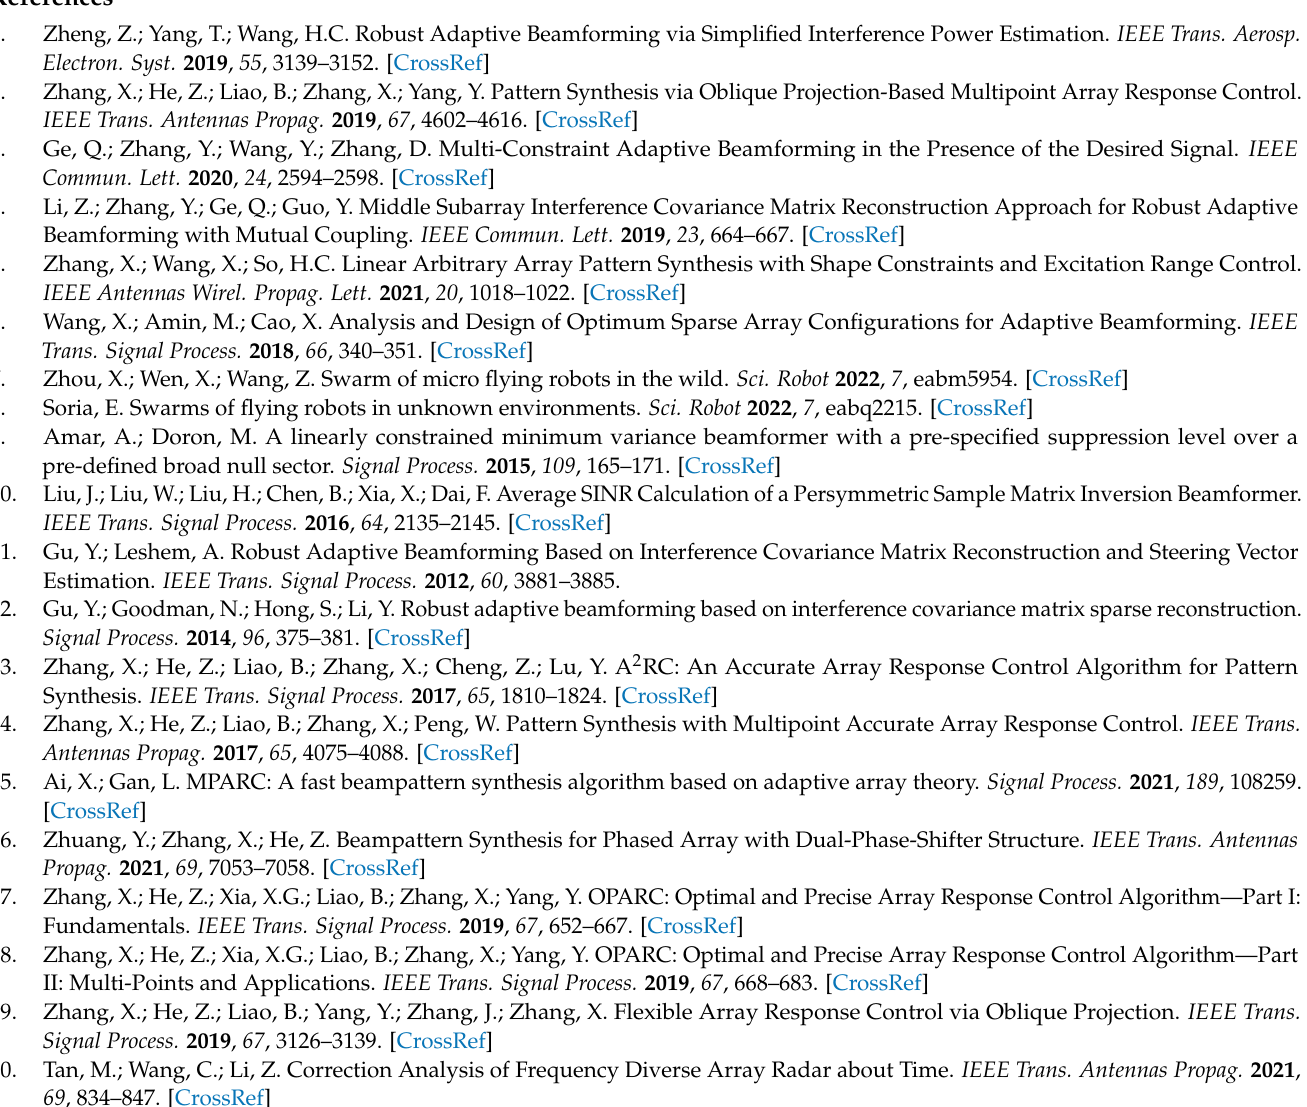
Figure A1. The diagram of complex number decomposition. ( a ) 0 < g < b ; ( b ) b ≤ g < 2 b .